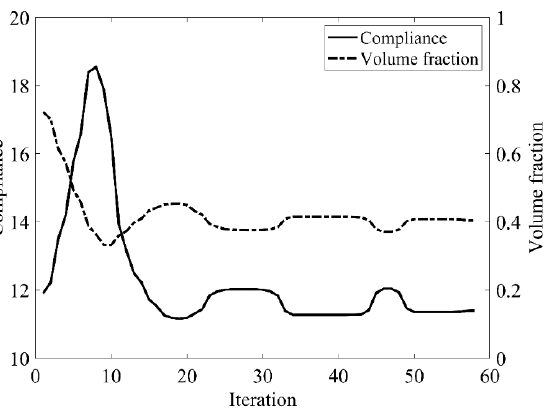
Figure 16. Convergence history of the compliance and the volume fraction for simple bridge beam by classical level set topology optimization.